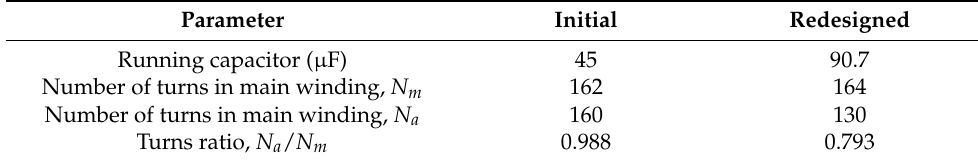
Table 3. The modified parameters tuning for the balanced-load condition at the rated load. Parameter Initial Redesigned Running capacitor ( µ F) 45 90.7 Number of turns in main winding, N m 162 164 Number of turns in main winding, N a 160 130 Turns ratio, N a / N m 0.988 0.793